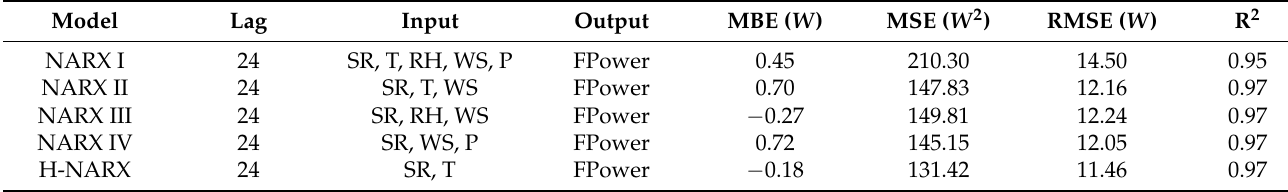
Table 8. Performance test results before applying the corrective vector multiplier.